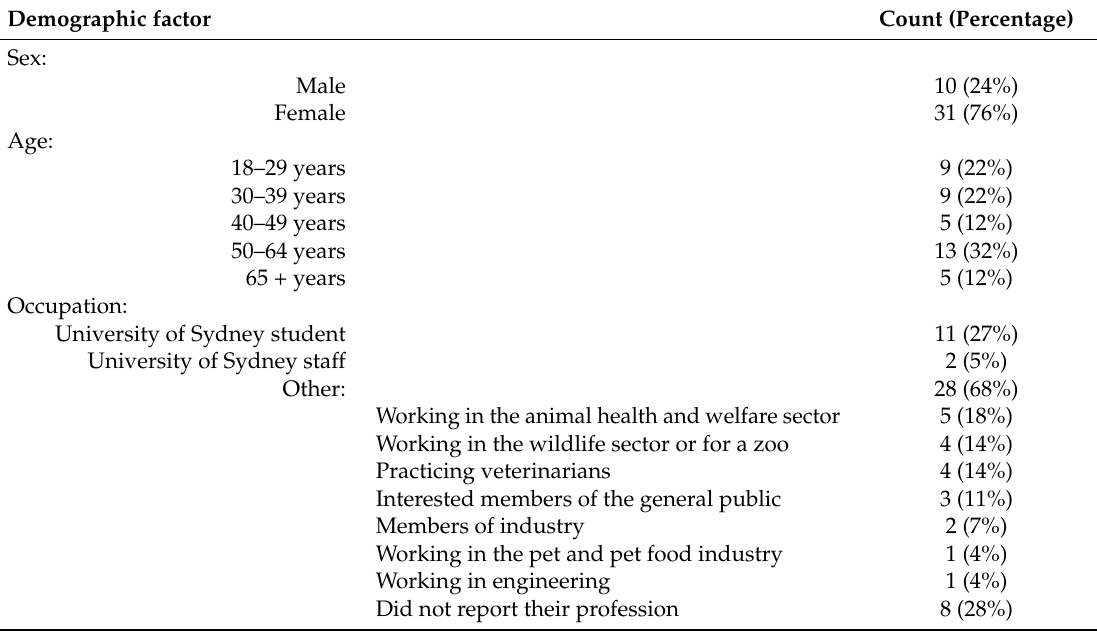
Table 1. The demographics of the participants ( n =